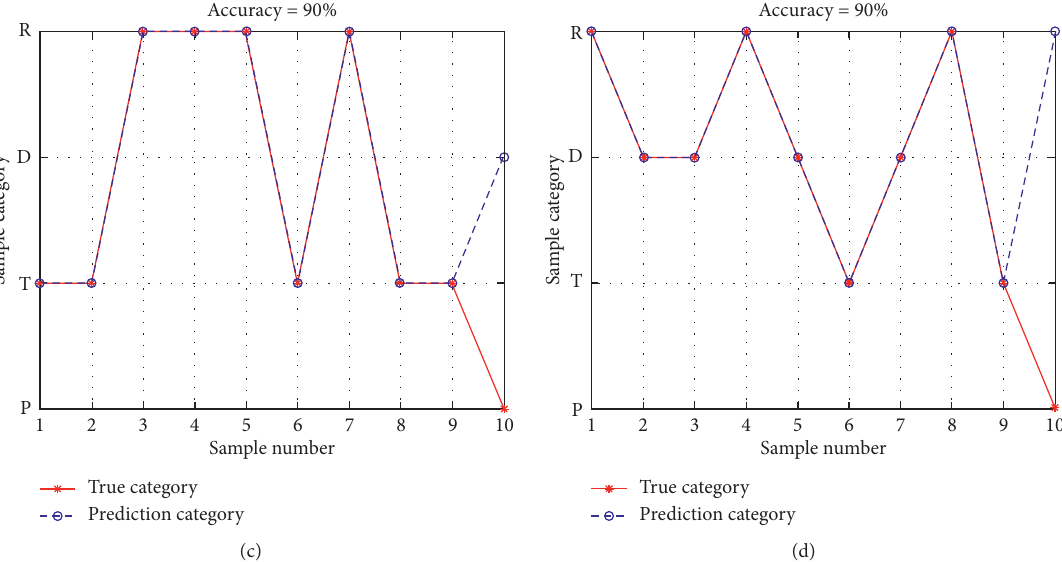
Figure 7: Comparison between the prediction results of SVM and the real situation. (a) First operation. (b) Second operation. (c) Third operation. (d) Fourth operation.